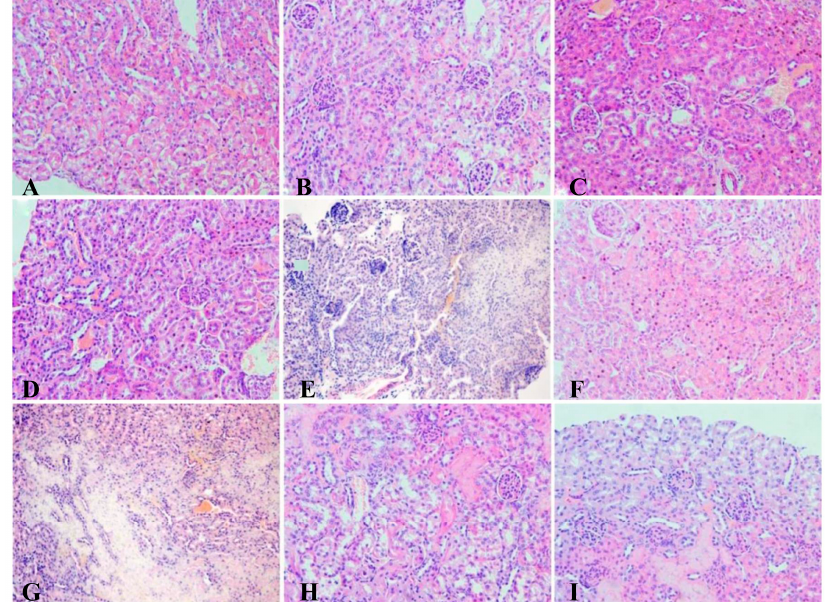
Figure 7. Representative photomicrographs of renal tissue of mice (hematoxylin-eosin (H&E) staining; magnification × 400): ( A ) Normal appearance of the renal tissue of mice in the control prevention group; ( B ) Renal tissue of mice in the pre-lead group; ( C ) Renal tissue of mice in the pre-LAB group; ( A ) Renal tissue of mice in the control therapy group; ( B ) Renal tissue of mice in the lead-only therapy group; ( C ) Renal tissue of mice in the high-dose therapy group; ( D ) Renal tissue of mice in the medial-dose group; ( E ) Renal tissue of mice in the low-dose group; and ( F ) Renal tissue of mice in the drug group.